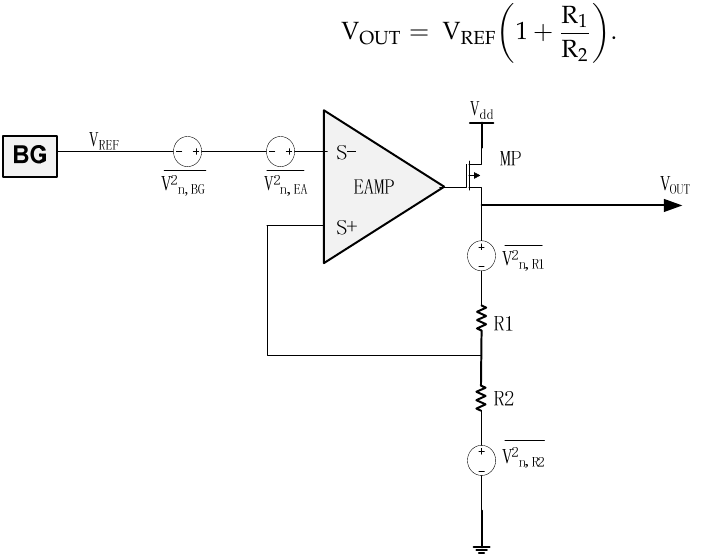
Figure 3. Conventional low-dropout (LDO) regulator structure. BG: bandgap reference.